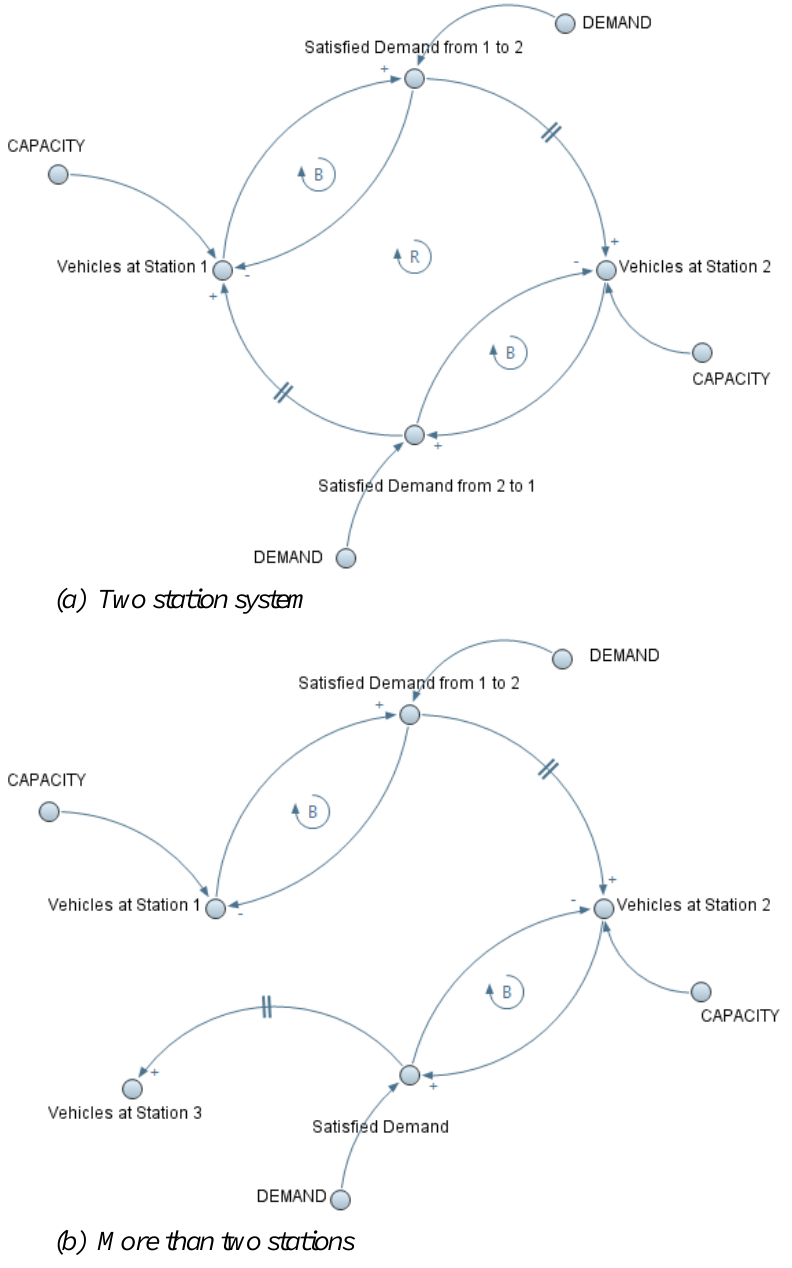
Figure 1 – Feedback in one-way carsharing